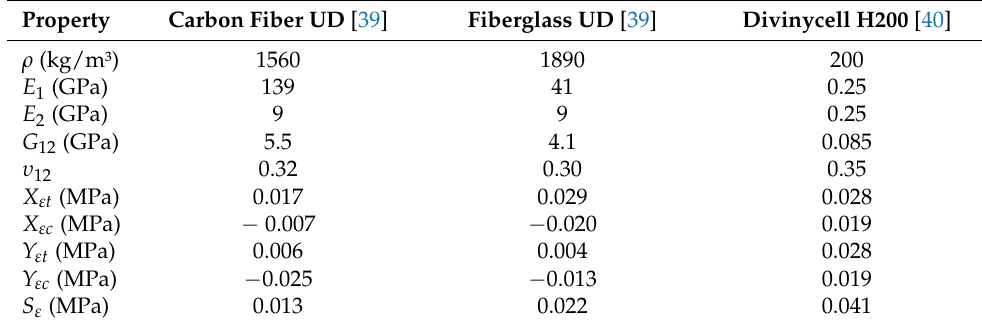
Table 1. Material’s mechanical properties.